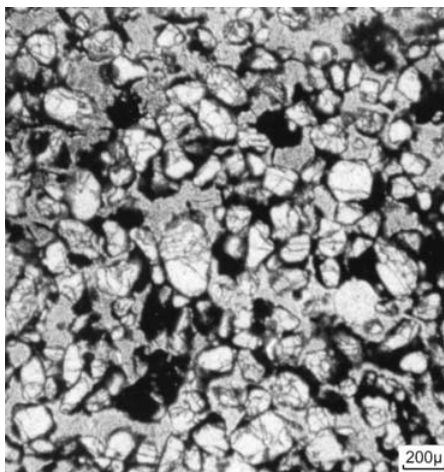
Figura 6. Porosidade de empilhamento composto fortemente comunicante no horizonte Bw do perfil